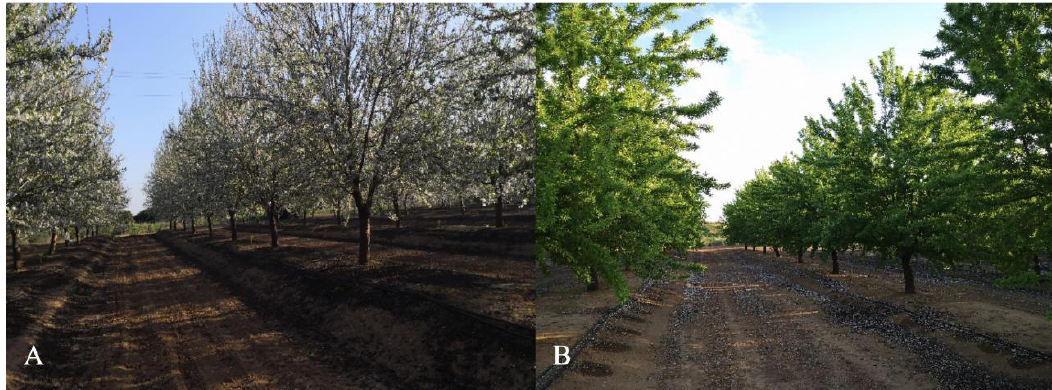
Figure 1. Experimental plot. Flowering ( A ) and vegetative ( B ) phenological period.